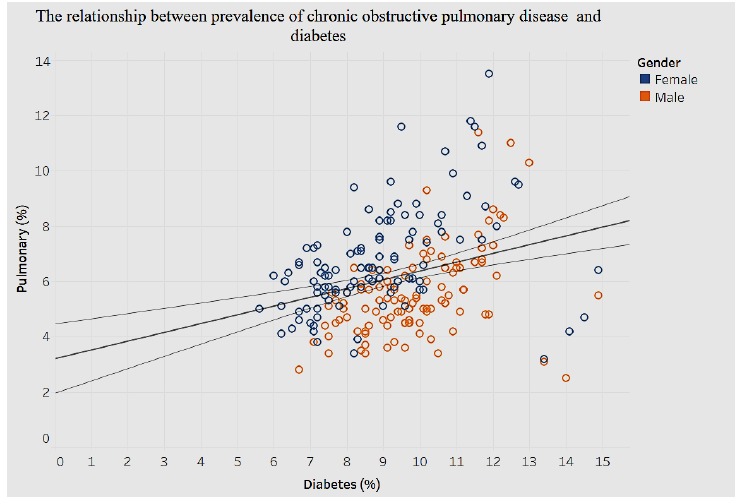
Figure 25. Diabetes by obstructive pulmonary disease.